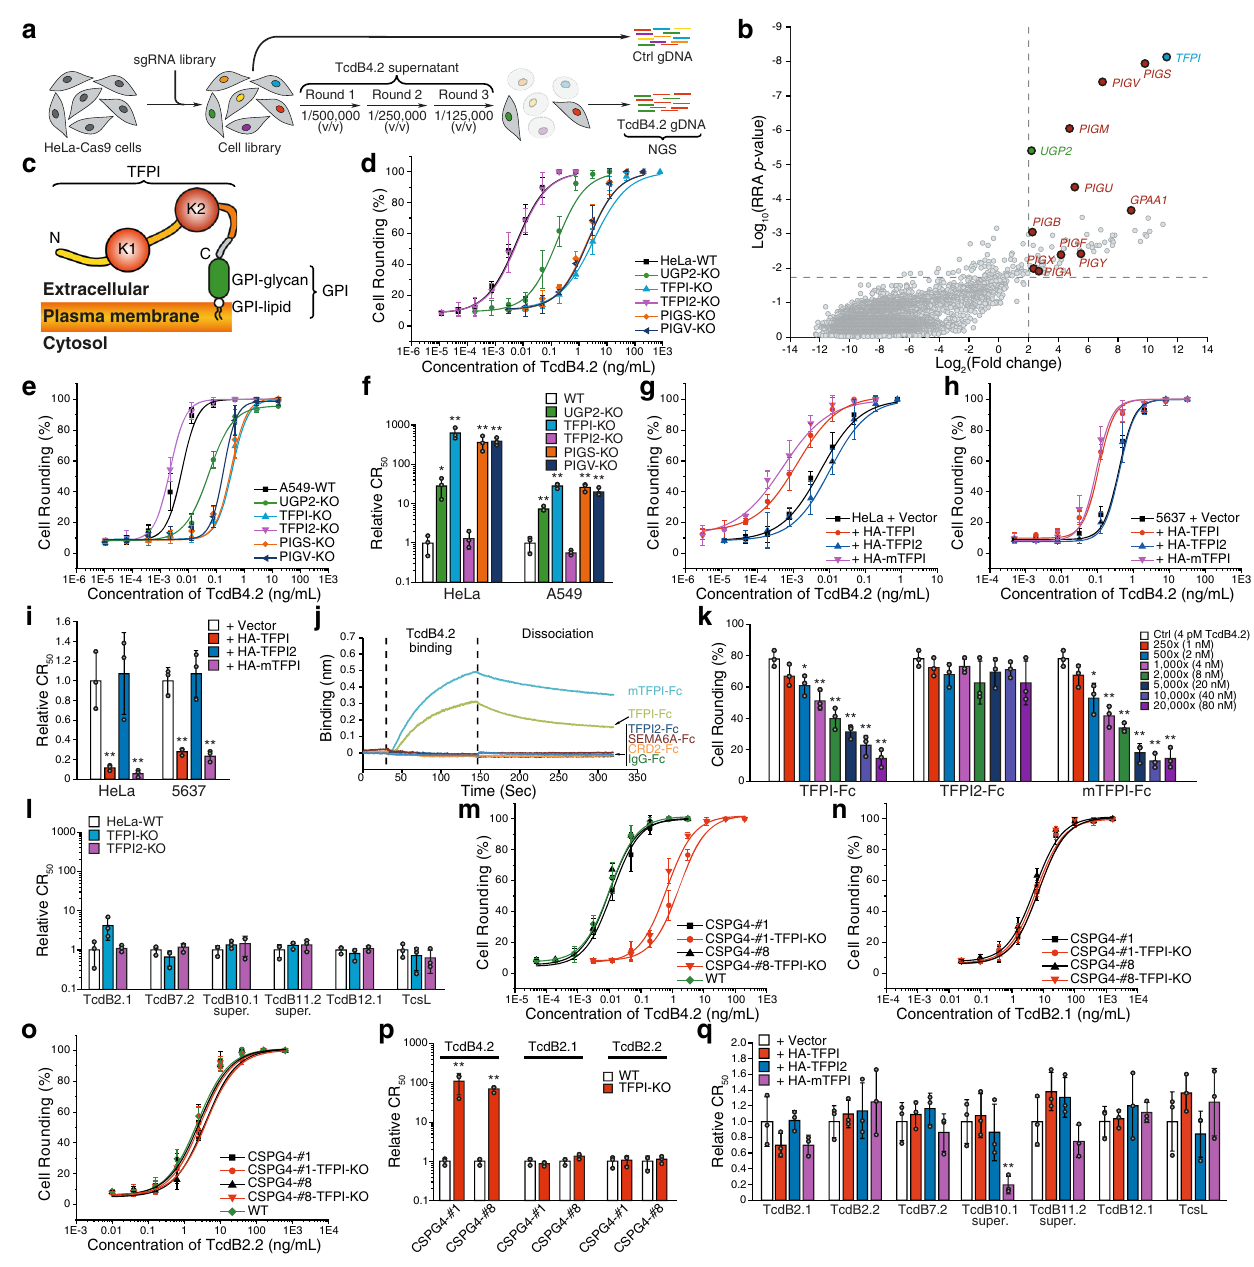
instance, TcdB6 has only a singleresidue differencefrom TcdB1across key CSPG4-binding residues: D1812 in TcdB1 becomes G1812 in